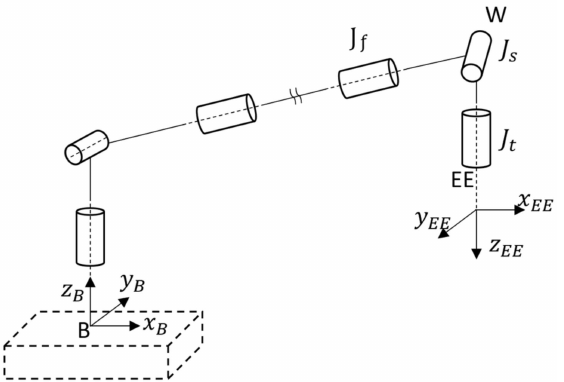
Figure 1. Kinematic model of a 6-DoF manipulator with focus on the spherical wrist, where the center of the spherical wrist (W) and the end-effector (EE) reference system are presented; a possible manipulator base reference system (B) is also